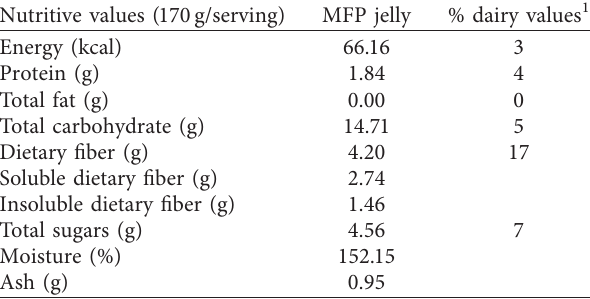
Table 3: Nutritive values and % dairy values of MFP jelly. Nutritive values